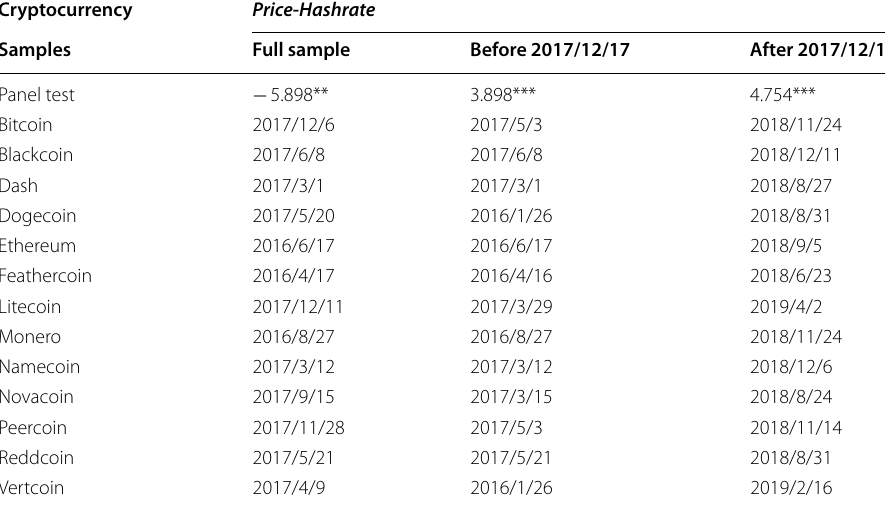
Panel bayesian information criterion is used to estimate the common factor ***Shows significance at the 1%